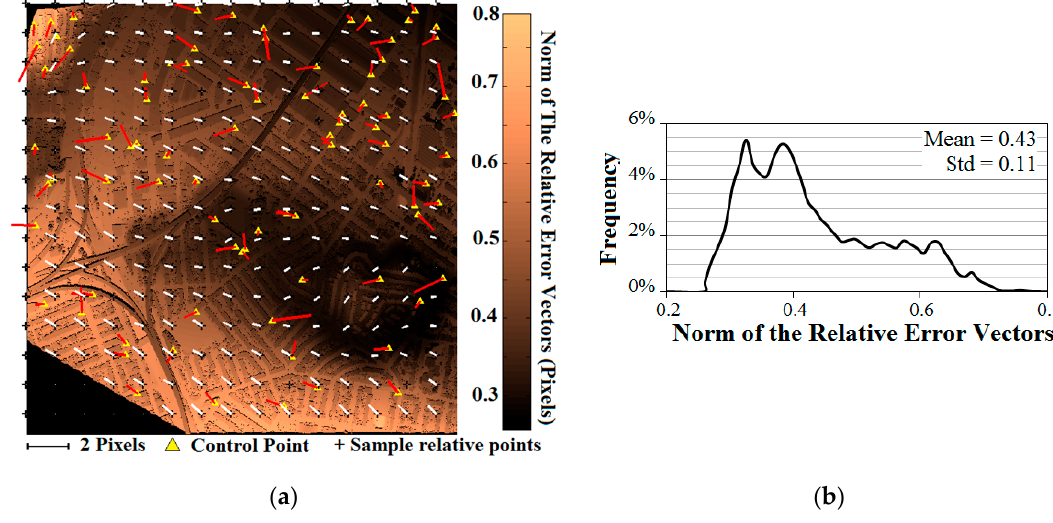
Figure 21. Absolute and relative error vectors with a histogram of the relative errors for the sample dataset: ( a ) Sizes and orientations of the error vectors; ( b ) Length histogram of the relative error vectors. Table 3. RMSE of the sample dataset’s control points estimated using the Fine 3D-Model. RMSE in